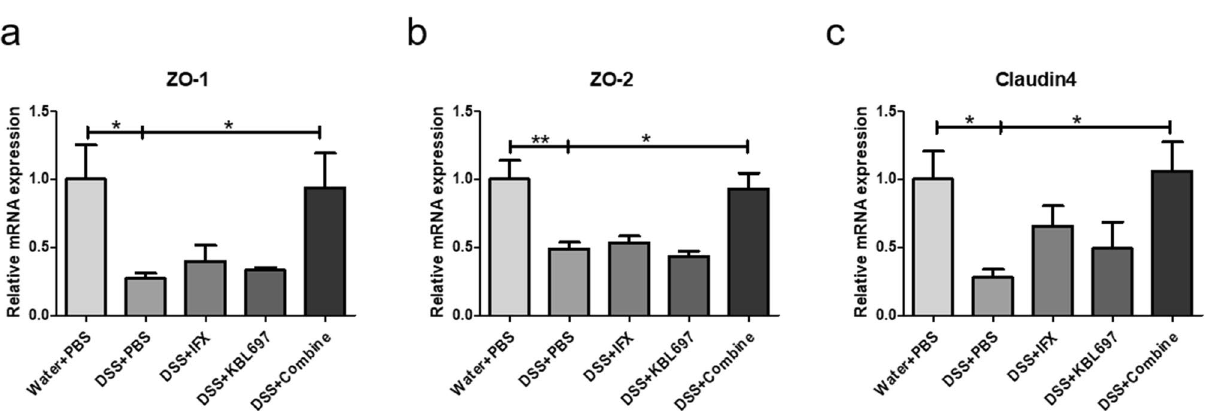
Figure 3. Effects of the different treatments on the mRNA expressions related to tight junction. ( a ) ZO-1. ( b ) ZO-2. ( c ) Claudin4. Statistical analysis was performed using one-way ANOVA with Dunnett’s post hoc test (* P < 0.05; ** P < 0.01; *** P <